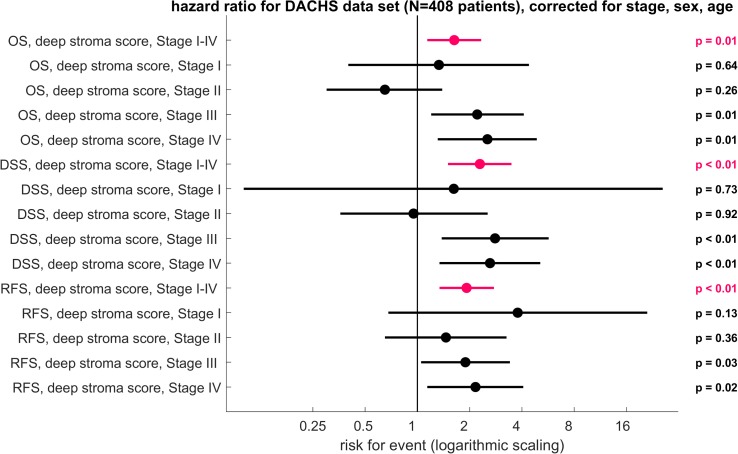
Deep stroma score applied to the validation data set (DACHS cohort).HRs with 95% CI in multivariable Cox models including cancer stage (I–IV), sex, and age for the deep stroma score. HR for OS, DSS, and RFS are plotted. The deep stroma score was stratified into high/low at the median of the training set. In this validation cohort, the deep stroma score was an independent prognostic factor over all stages and within stage III and stage IV tumors. The horizontal axis is scaled logarithmically (log 10). CI, confidence interval; DACHS, Darmkrebs: Chancen der Verhütung durch Screening; DSS, disease-specific survival; HR, hazard ratio; OS, overall survival; RFS, relapse-free survival.